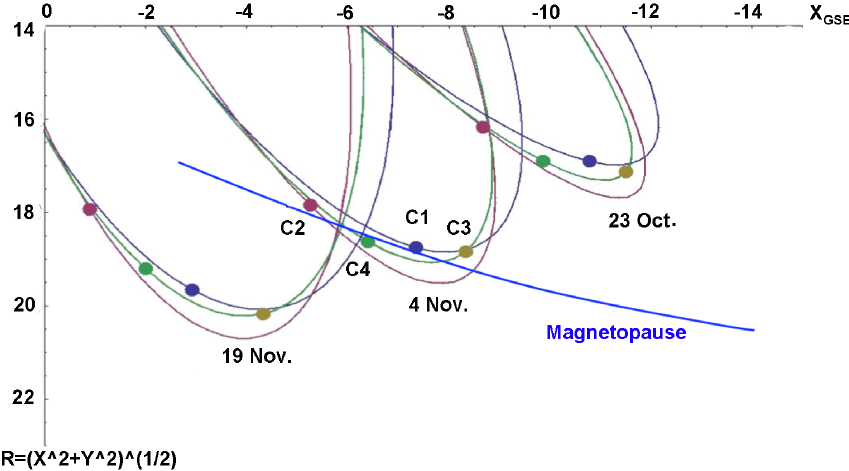
Fig. 12. Three orbits of Cluster during October and November 2012. The numbers indicate the spacecraft number. The model magnetopause is shown as blue line during the orbit on 4 November 2012 (courtesy of D. Sieg, ESOC, Germany).